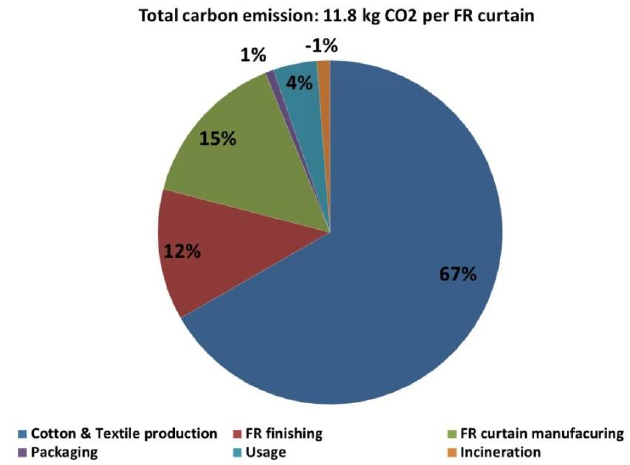
Figure 6. The percentage breakdown of carbon emissions by one kilogram of FR cotton curtains. Fibers 2016 , 4 , 16